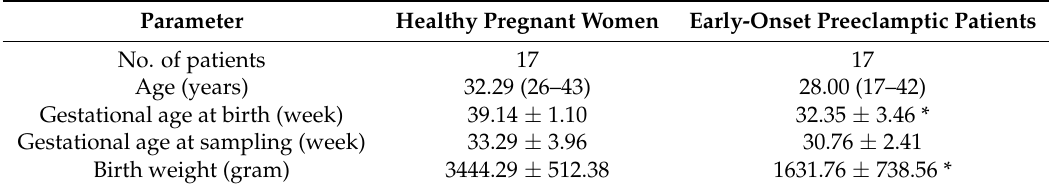
Table 2. Patients’ demographic and gynecological